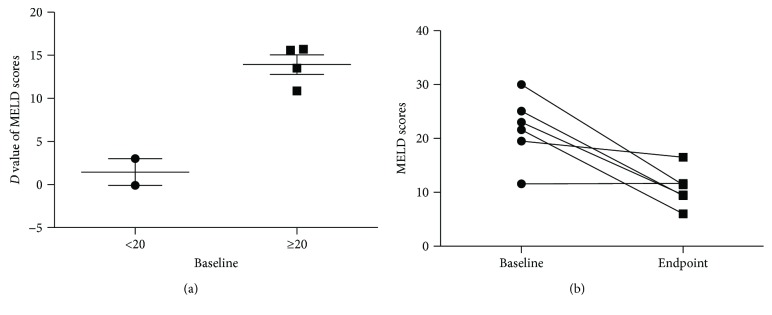
The level of MELD scores in LF. (a) MELD score baseline of ≥20 group had better efficacy compared with baseline of <20 group after MSCT; (b) the scores of MELD endpoint were concentrated in 10 points.